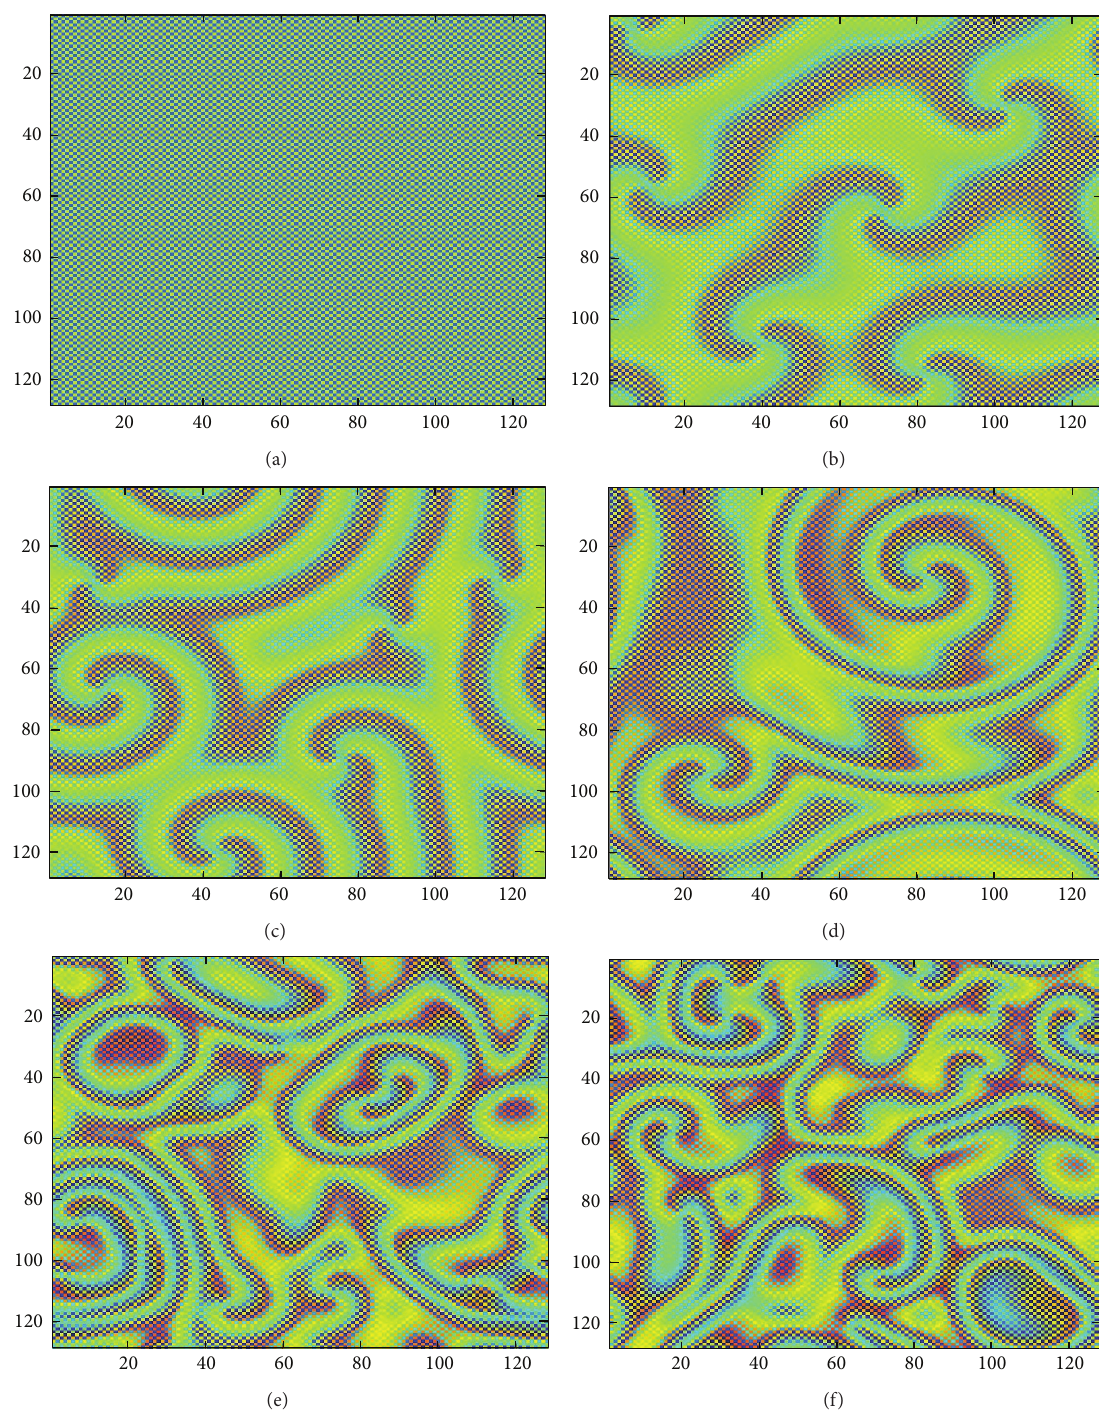
Figure 2: Pattern selection with the increase of 𝑑 2 in the Turing instability region when 𝑎 = 0.55 , 𝑟 = 0.71 , and 𝑑 1 = 0.22 . (a) 𝑑 2 = 0.195 . (b) 𝑑 2 = 0.20 . (c) 𝑑 2 = 0.205 . (d) 𝑑 2 = 0.21 . (e) 𝑑 2 = 0.215 . (f) 𝑑 2 = 0.217 .